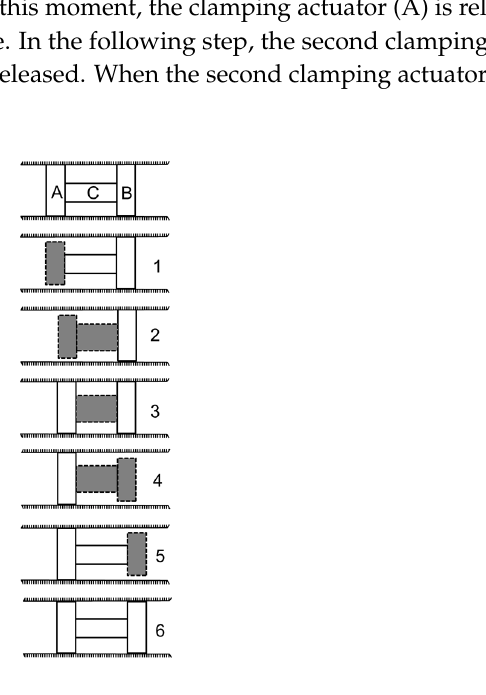
Figure 1. Motion sequences of a piezo-walk-drive motor proposed by Brisbane in 1965 [17].